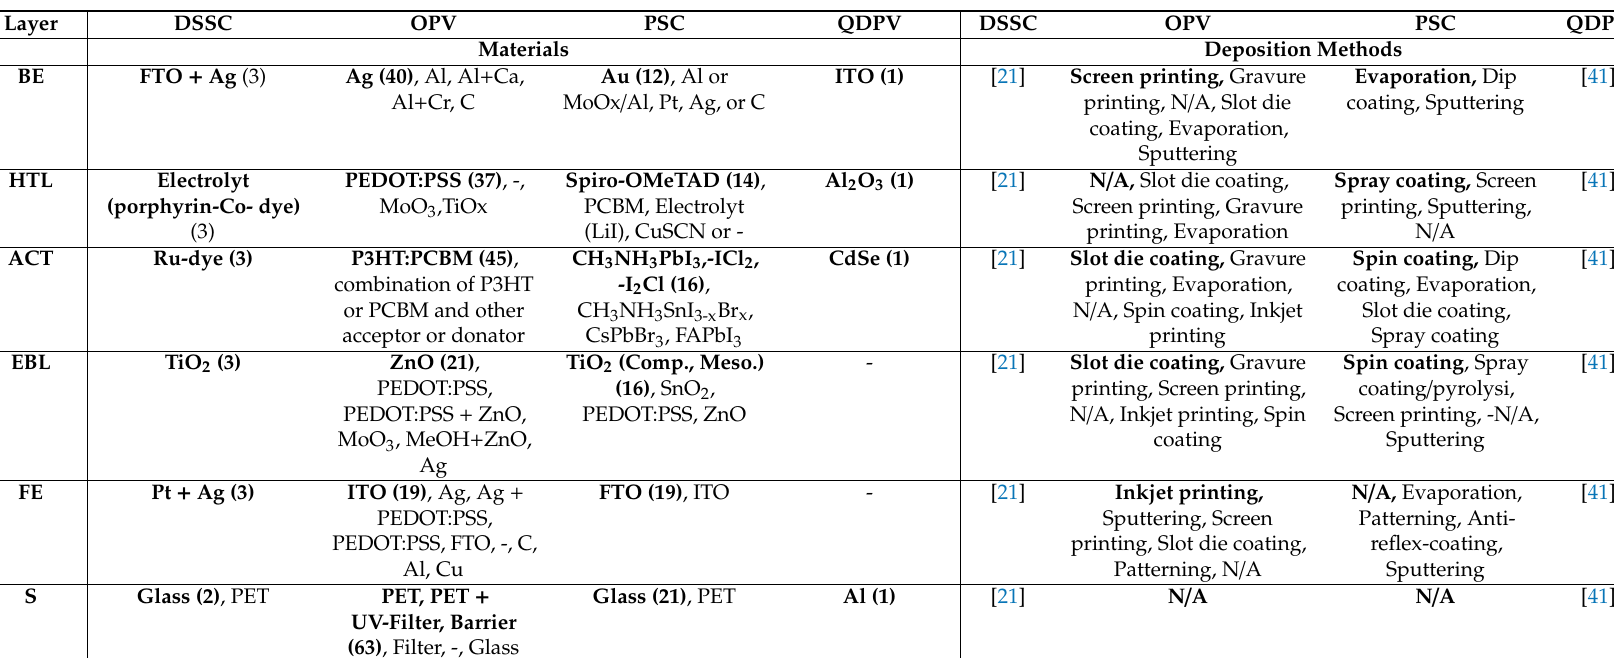
Table 1. Overview of the layer materials and deposition methods of emerging photovoltaic technologies (PVs; summarized from life-cycle assessment (LCA) literature); in bold, the most assessed materials and deposition methods of each layer (with frequency) are